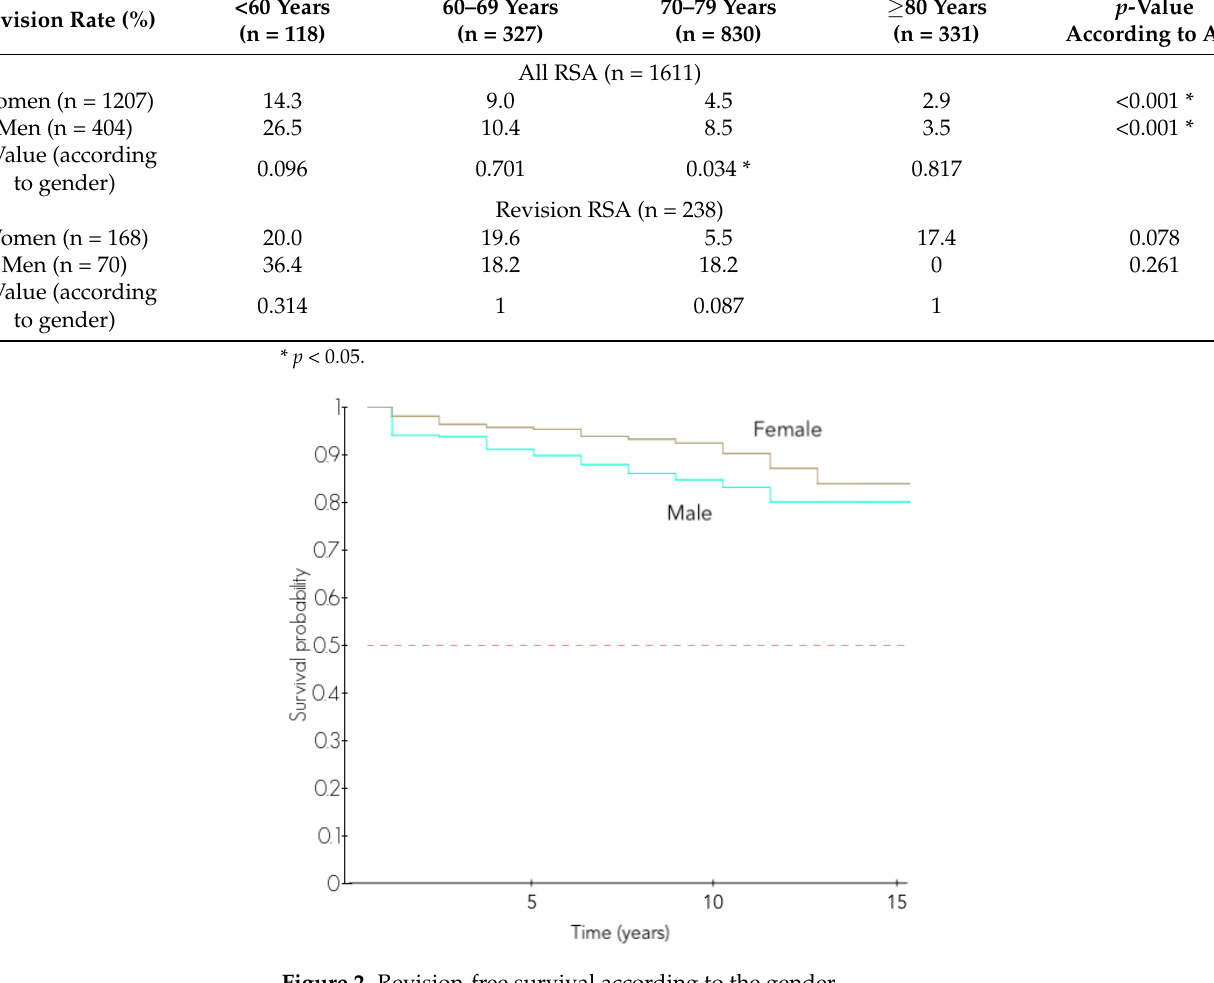
Figure 2. Revision-free survival according to the gender.